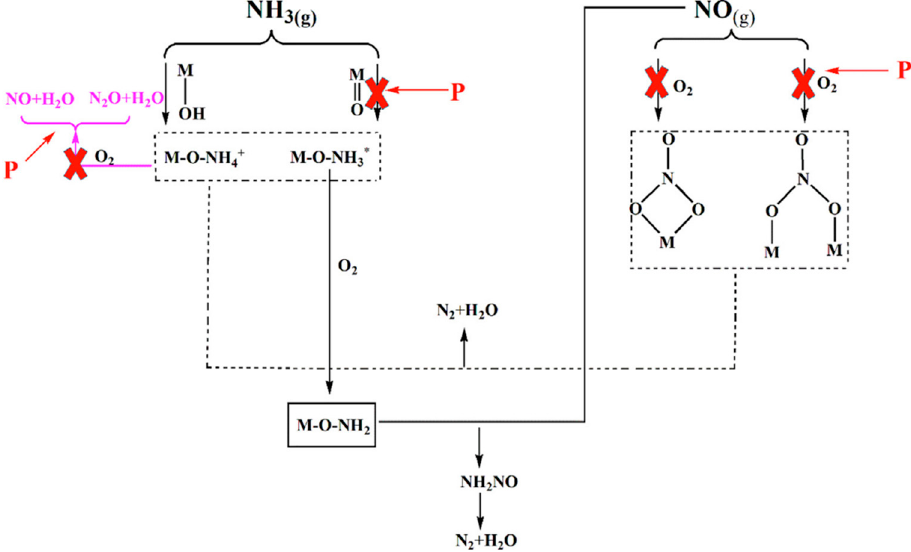
Figure 20. The effect of phosphorus on the reaction pathway for NH 3 -SCR of NO over CT catalyst [84].